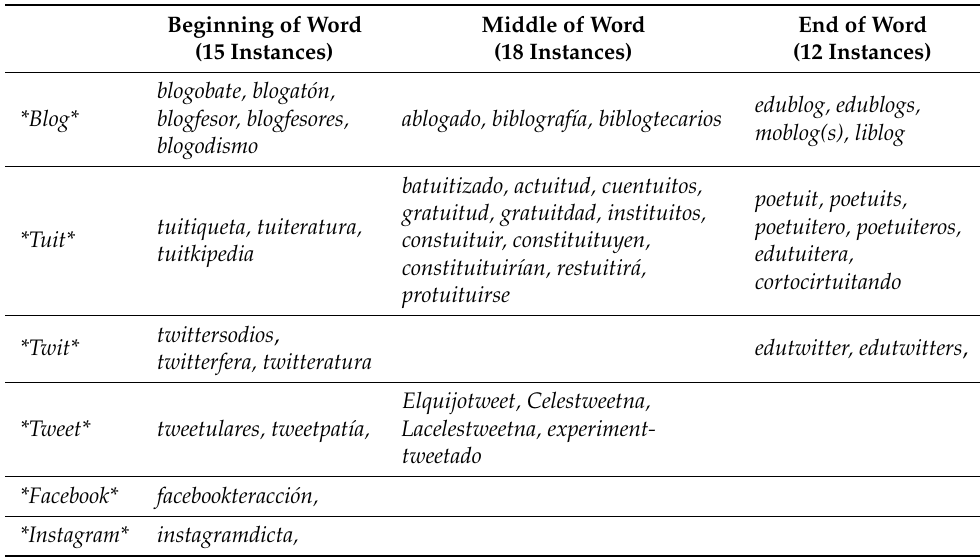
Table 5. Blends attested in our corpus-based